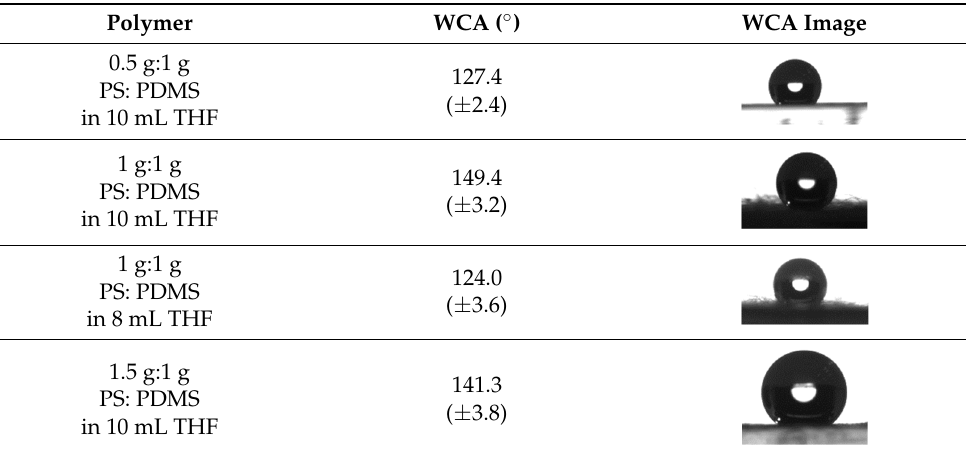
Table 2. Properties of prepared PS/PDMS fiber mats.